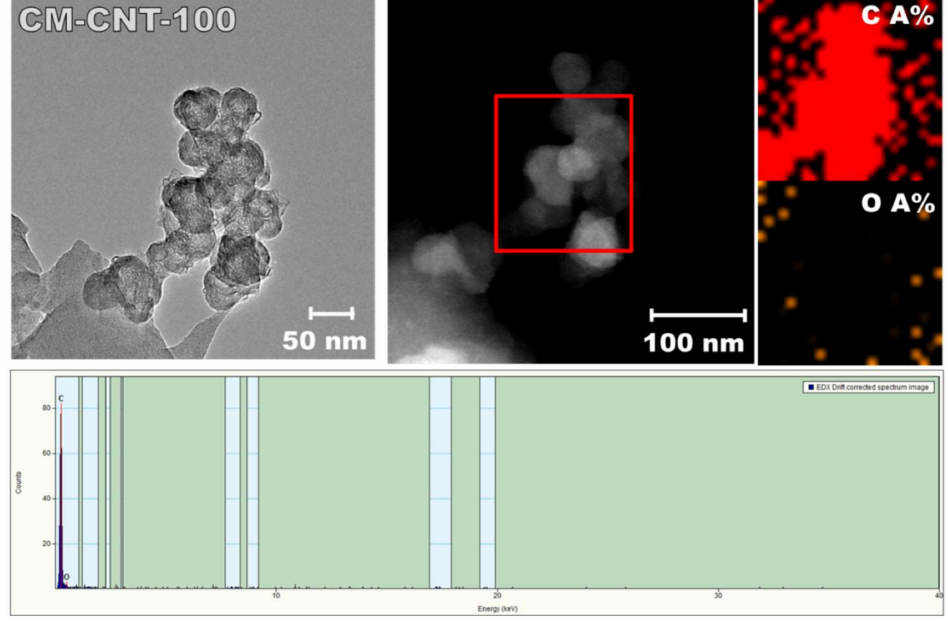
Figure 4. Energy-dispersive X-ray spectroscopy (EDX) analysis of TEM-modified membrane (CM-CNT-100): presence of carbon and